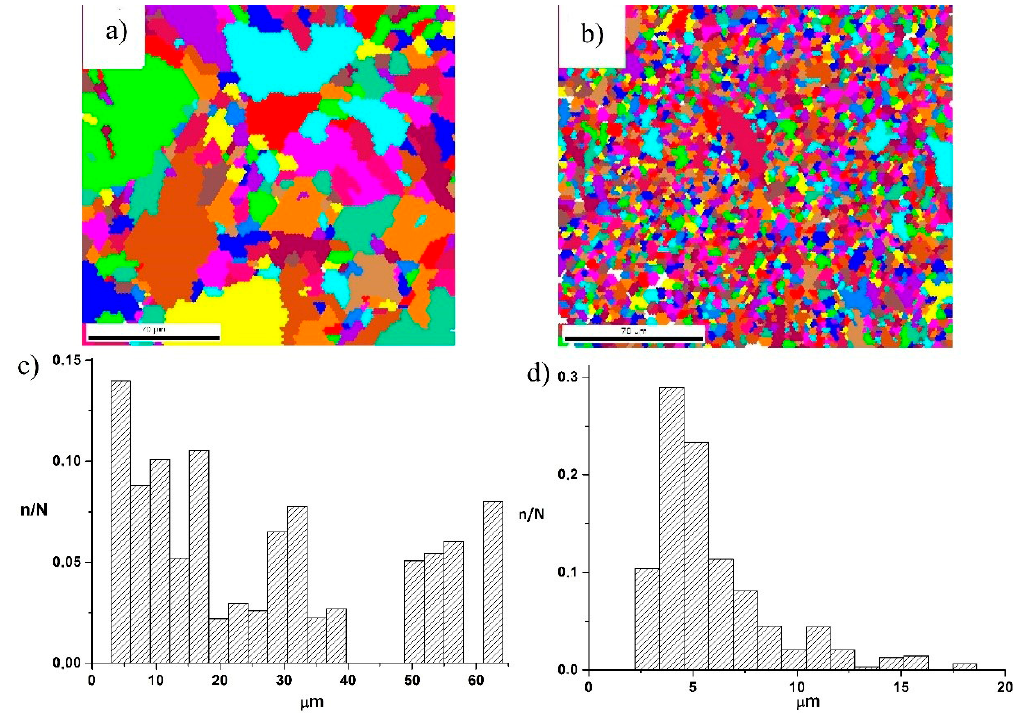
Figure 3. Structure and size distribution of grains ( a , c ) in the AA6082 alloy and ( b , d ) in the composite AA6082-0.2 wt % Al 2 O 3 after combined rolling.